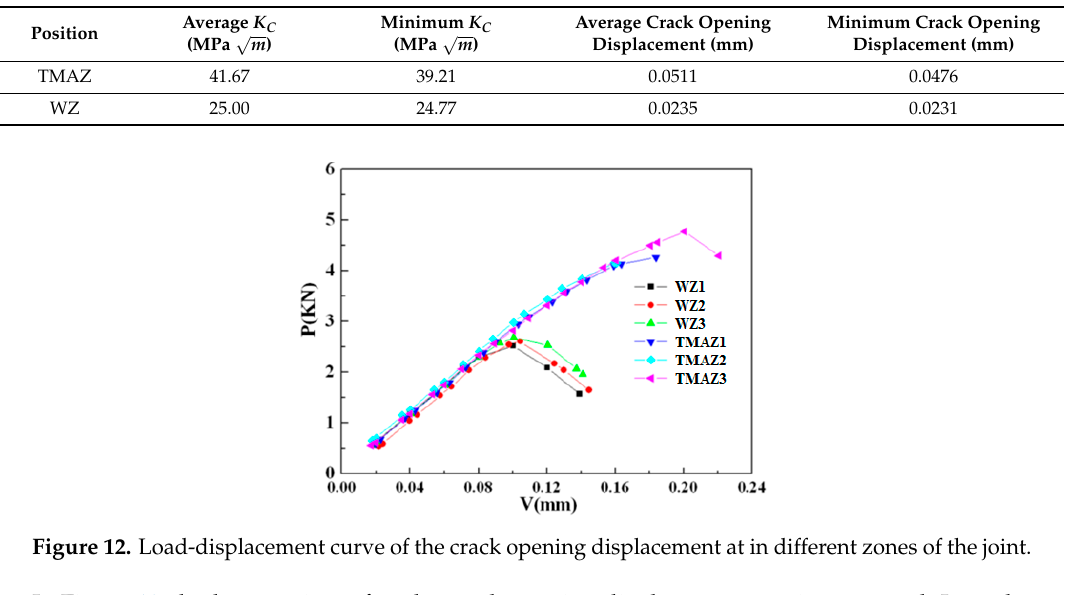
Table 2. Fracture toughness of the joint.